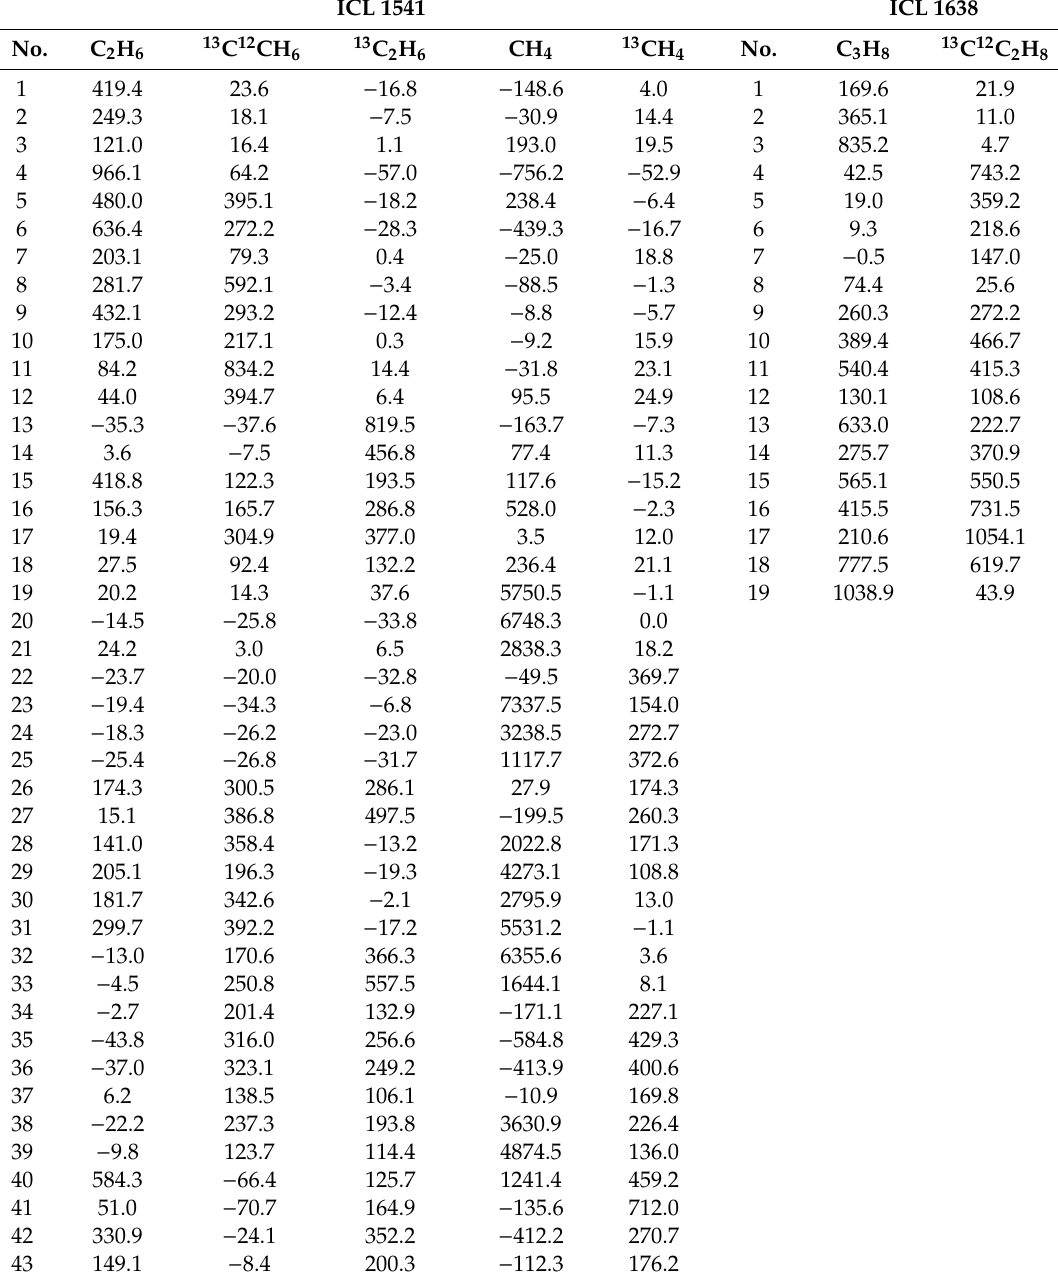
Table A2. Hydrocarbon concentrations of the gas mixtures in ppmv determined by the PLRS